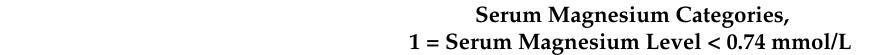
Table 7. Logistic regression (both adjusted and unadjusted) for MetS components (dependent variables) with hypomagnesemia (independent